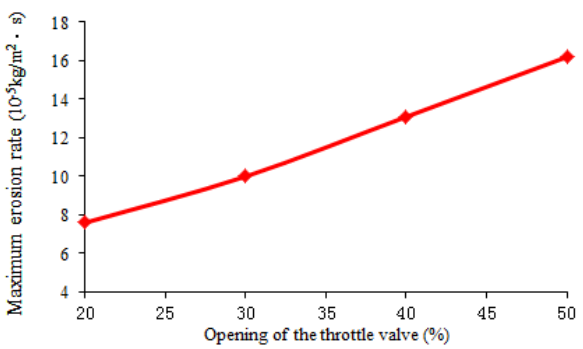
Figure 11. Curve of the maximum erosion rate versus the throttle valve opening.